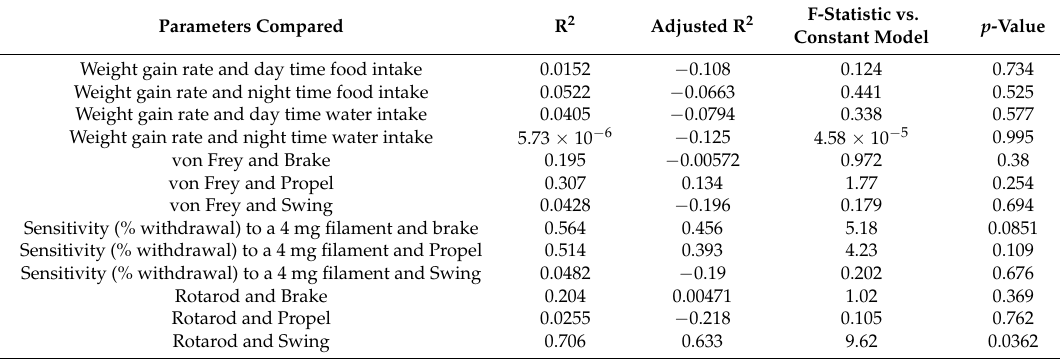
F-Statistic vs. p -Value Constant Model